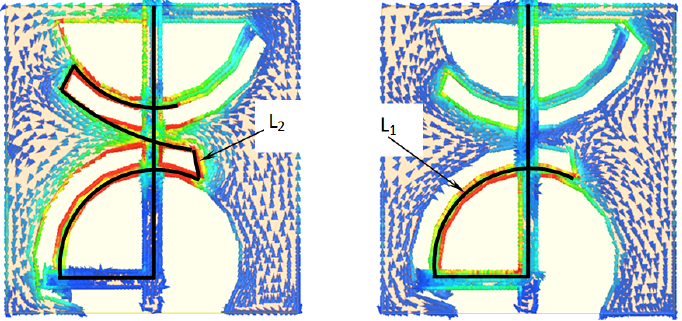
Figure 10. Current paths and antenna effective electric lengths.